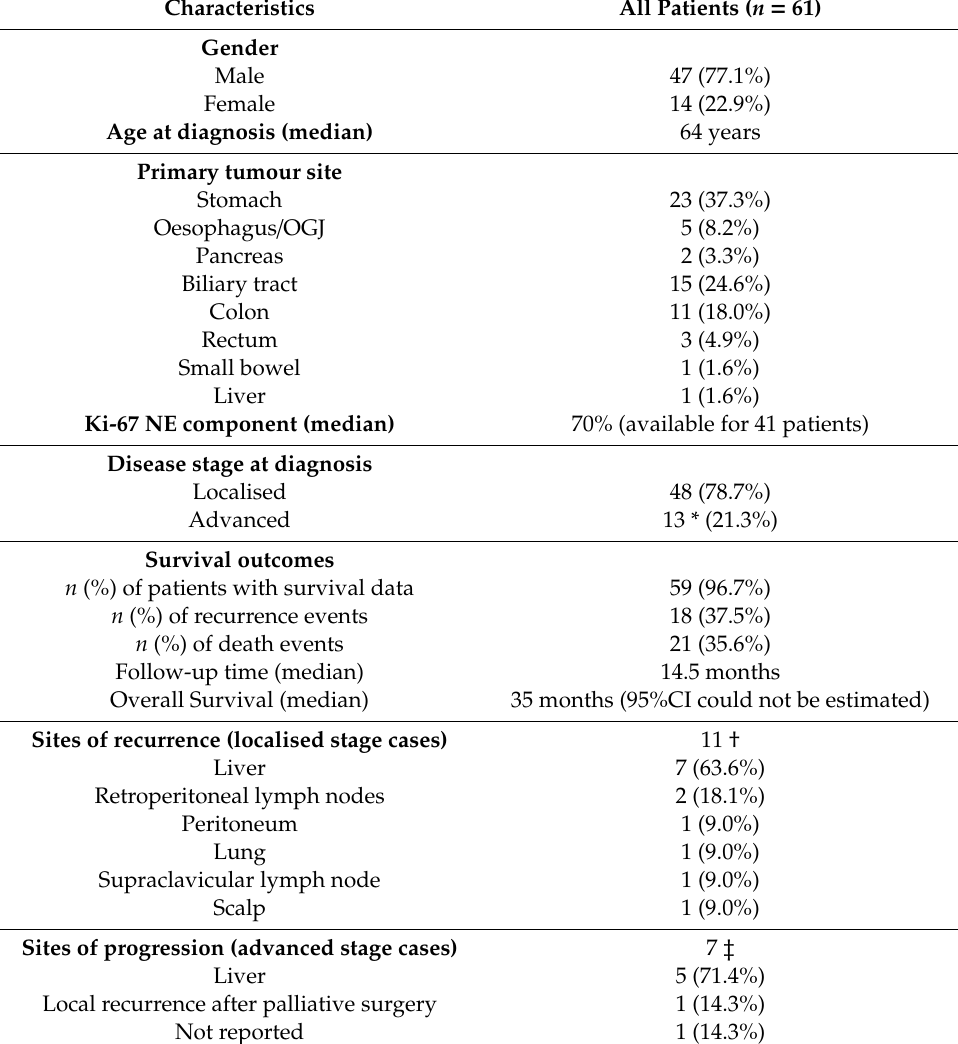
Table 1. Clinical-pathological characteristics and survival outcomes of patients with a diagnosis of mixed neuroendocrine non-neuroendocrine neoplasm in case